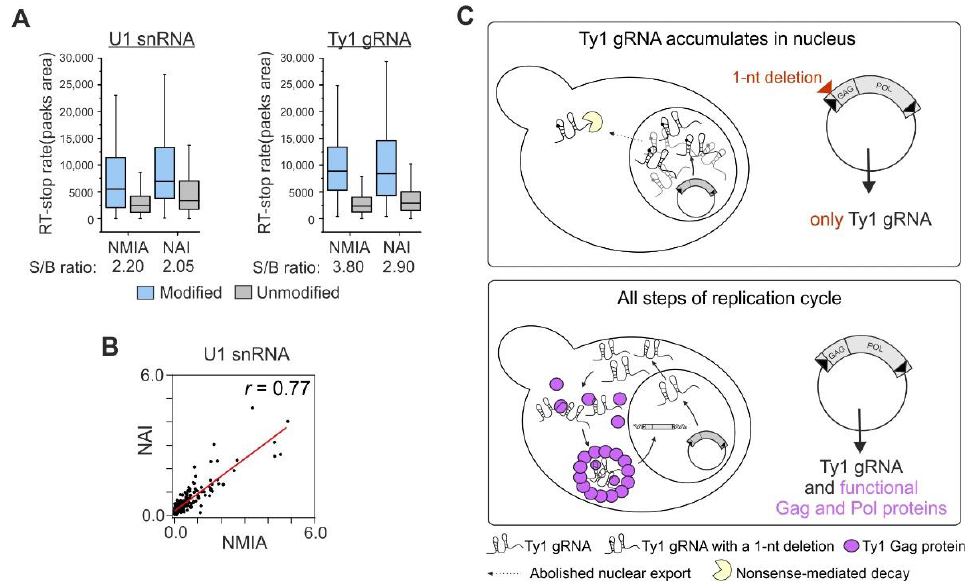
Figure 1. Yeast strains used for Ty1 gRNA structural studies and analysis of the ability of NMIA to modify yeast nuclear RNA. ( A ) Box plot analysis of RT-stop rate measurement with medians for signal and background for U1 snRNA and Ty1 gRNA. Plots present data for approximately 340 nts and 400 nts of U1 snRNA and Ty1 gRNA, respectively. ( B ) Correlation of position-dependent NMIA and NAI reactivities for U1 snRNA (data for 230 nts). ( C ) Comparison of DG3408 (pGTy1fs) and DG3412 (pGTy1 wild type) yeast strains.